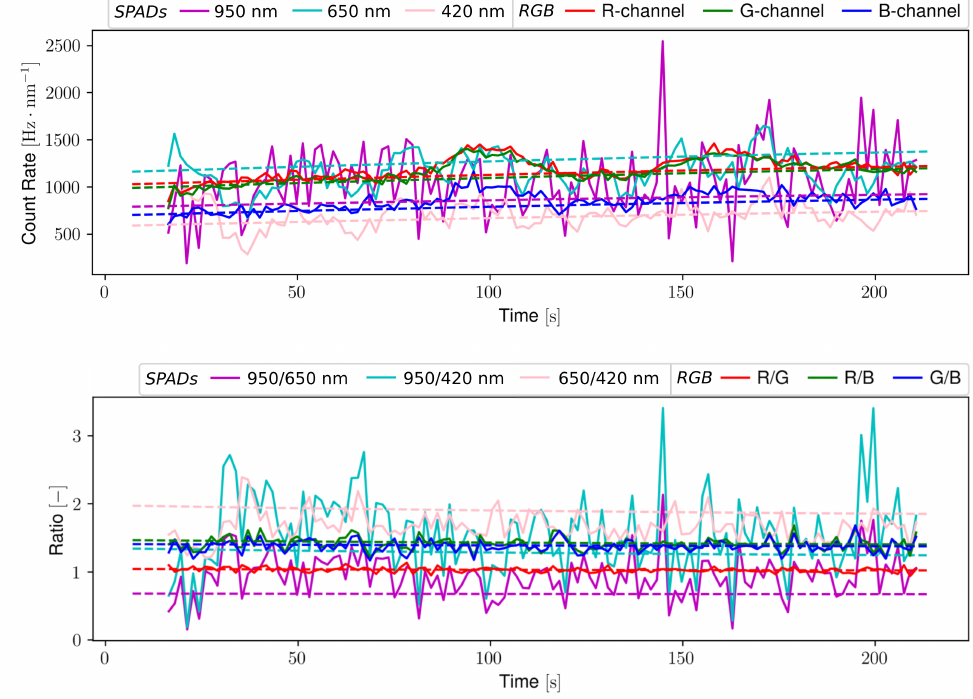
Figure 10. Comparison of simulated (dashed line) to measured (continuous line) data for a pass of LCS 1 on 27/11/2020. ( above ): count rates, ( below ): signal